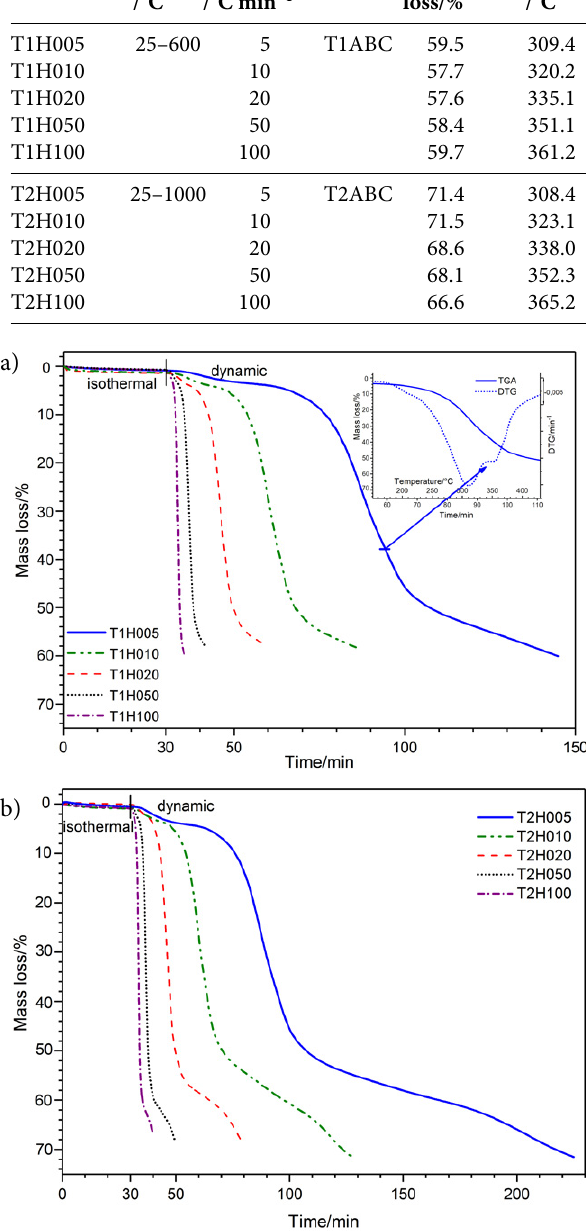
Figure 1. Dynamic TGA curves of the MBM pyrolysed up to 600 °C (a) and pyrolysed up to 1000 °C (b) measured with five